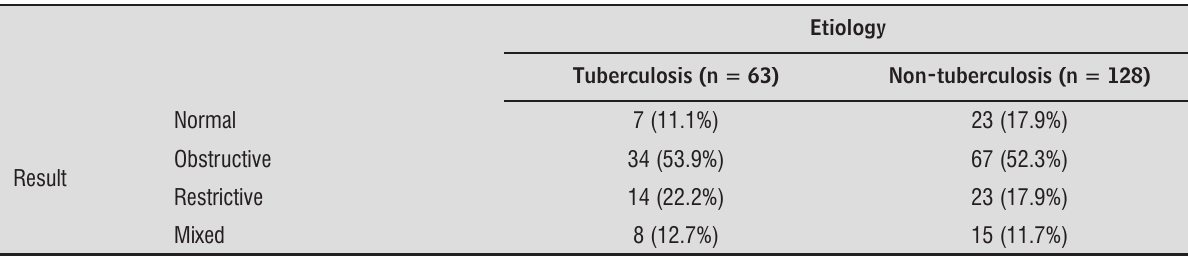
Table 4 – Distribution of spirometric pattern in patients with non-cystic fibrosis bronchiectasis according to etiology (tuberculosis versus non-tuberculosis)